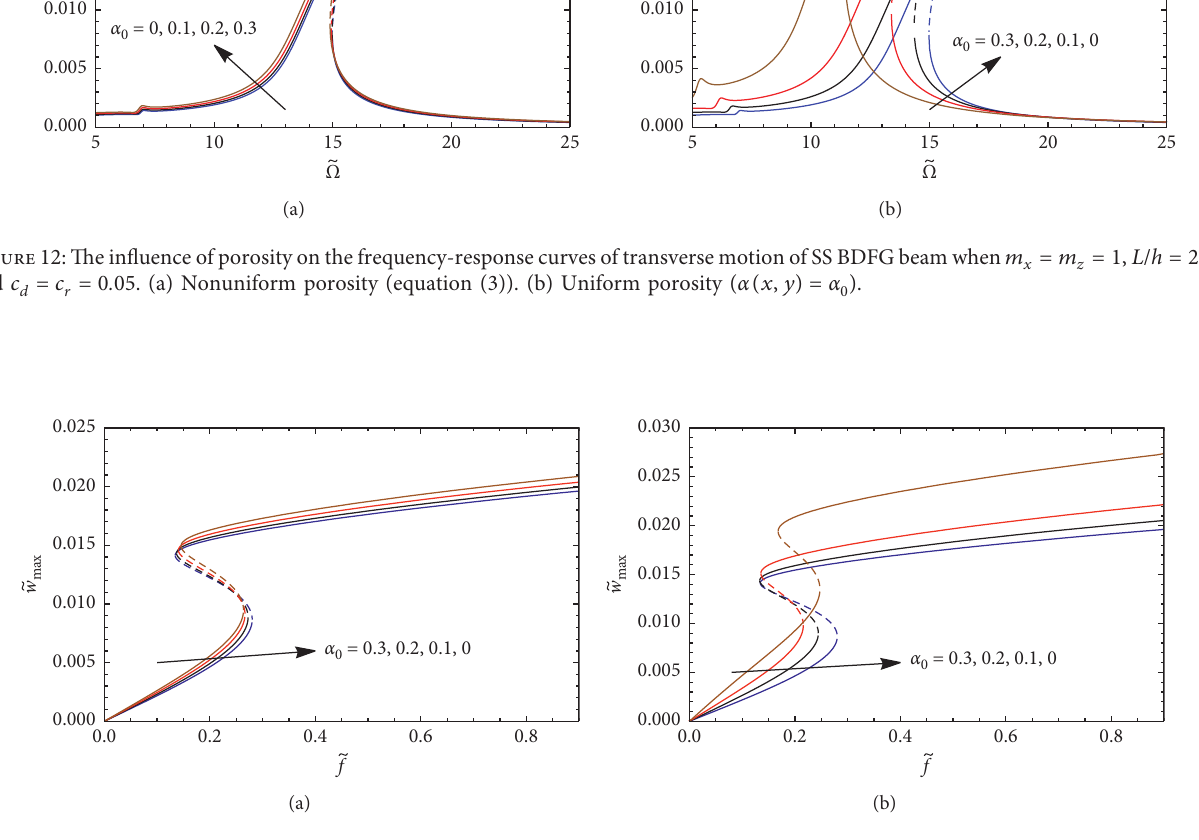
� m � 1, L / h � 20, and x z